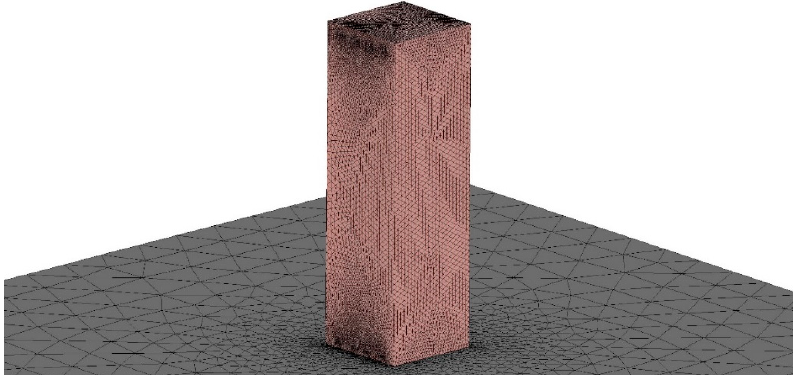
Figure 8. A general overview of the mesh used in the numerical experiment.